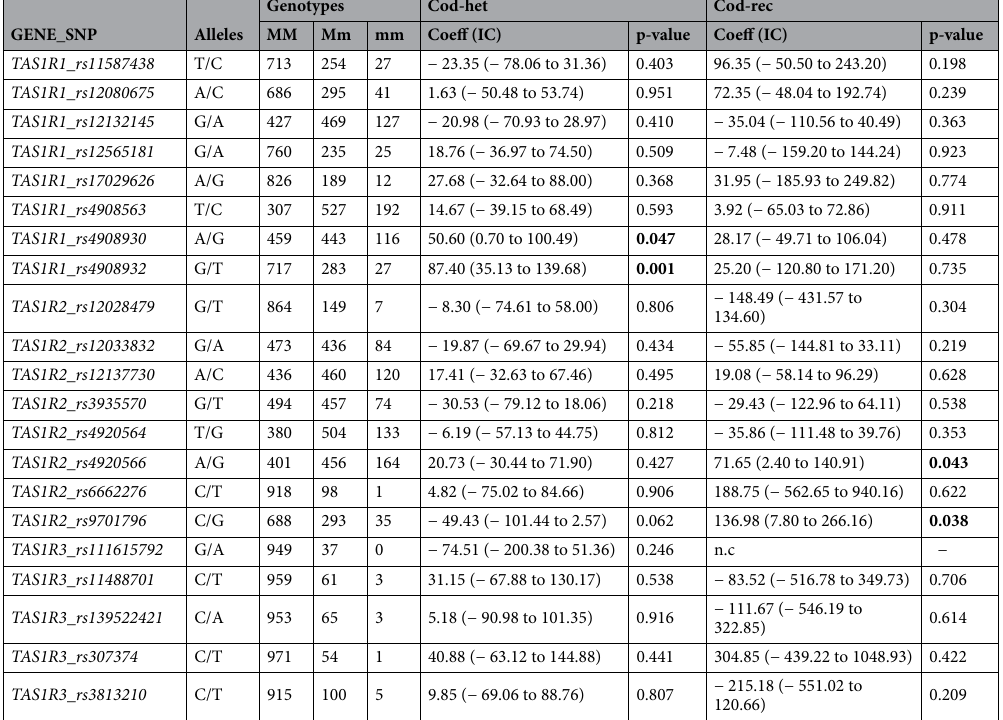
Table 3. Results of the association analysis between epidemiologic variables and genotypes on birthweight . Values in bold are significant at the conventional level of p <